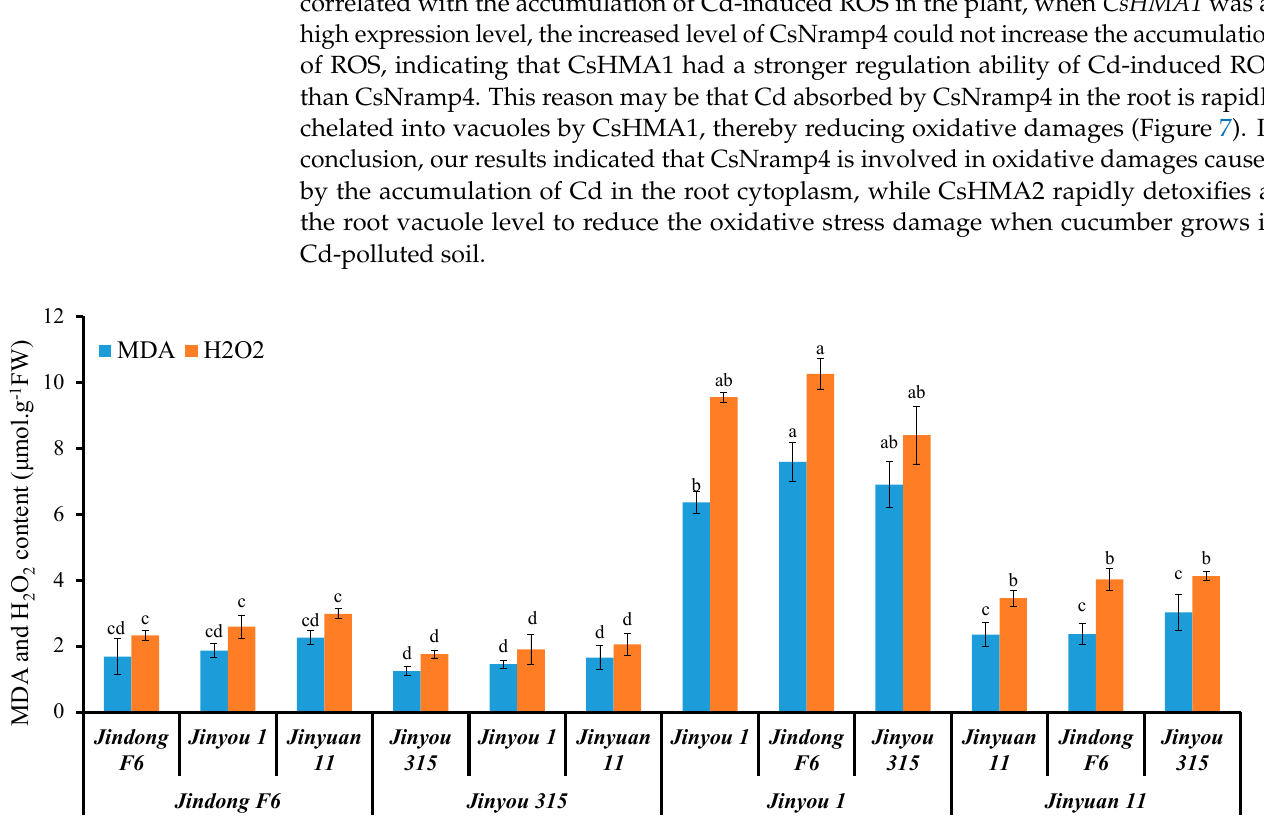
Figure 7. Oxidative stress level in cucumber seedlings with different grafting combinations exposed Cd stress. MDA and H 2 O 2 content in seedlings of cucumber with different graft combinations under 0.5 μ M Cd treatment. Ten-day-old cucumber plants were selected for grafting. After 7 days of growth in the vermiculite surrounded by Yamazaki nutrient solution, the live seedlings were supplemented with 0 and 0.5 μ M Cd for 48 h and 4 days. Different letters on the bars indicate that the mean values are significantly different between Jinyou12 lines and other combinations ( p < 0.05).